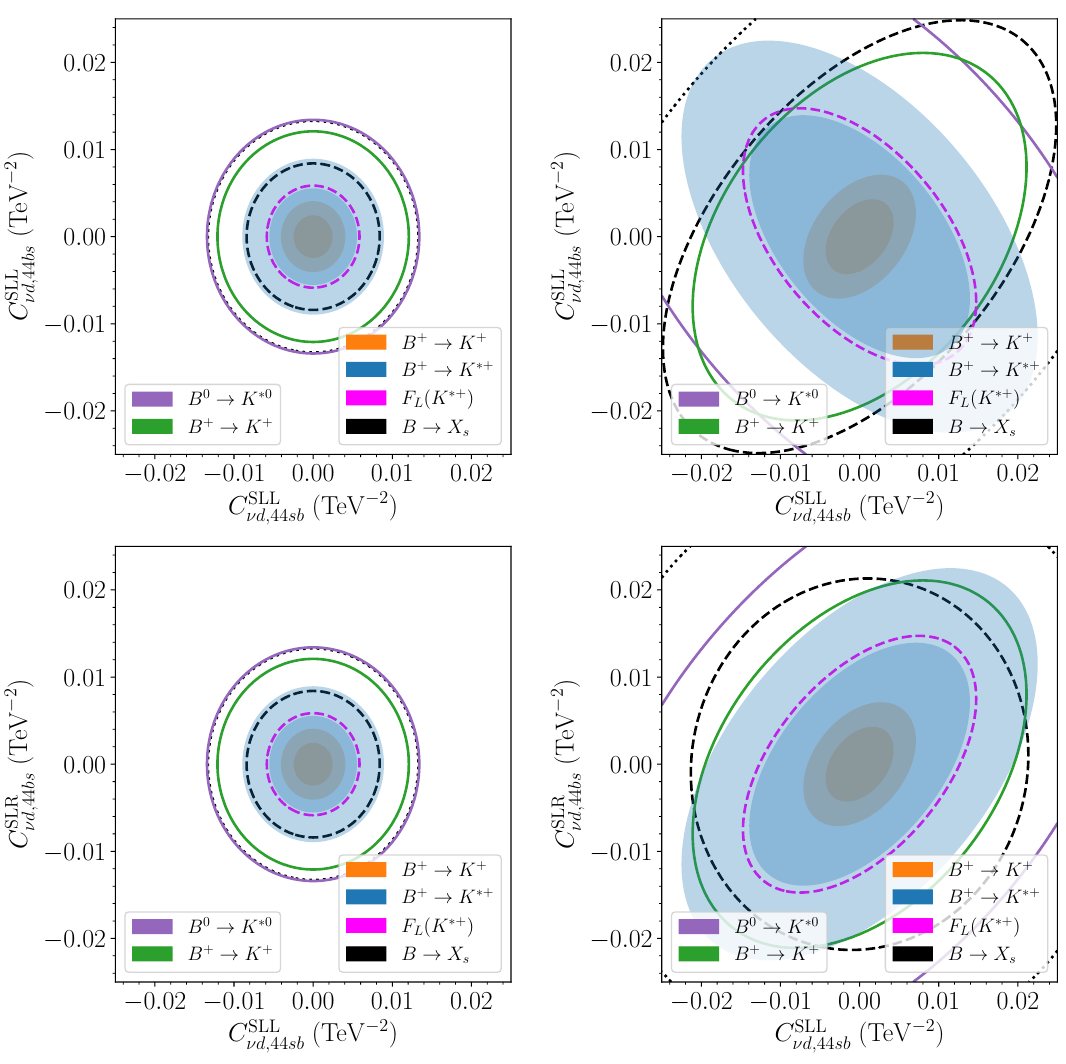
Figure 6 . Future sensitivity of Belle II for 5 ab − 1 (light shaded regions) and for 50 ab − 1 (dark shaded regions, dashed lines) to scalar Wilson coefficients with sb and bs quark-flavour ordering and massive sterile neutrinos following the same analysis as in figure 2. The solid dark purple and green lines indicate the current experimental bound, see table 1. Left: m 4 = 0 GeV; right: m 4 = 1 . 5 GeV. (1 . 1 ± 0 . 4) × 10 − 5 [4, 8] which is above the SM expectation Br ( B + → K + νν ) = (4 . 4